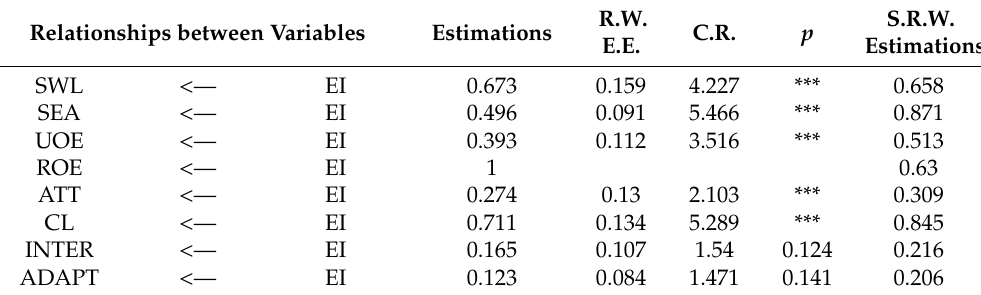
Figure 1. Multi-group structural equation model for men. Table 5. Regression weights and standardized regression weights for